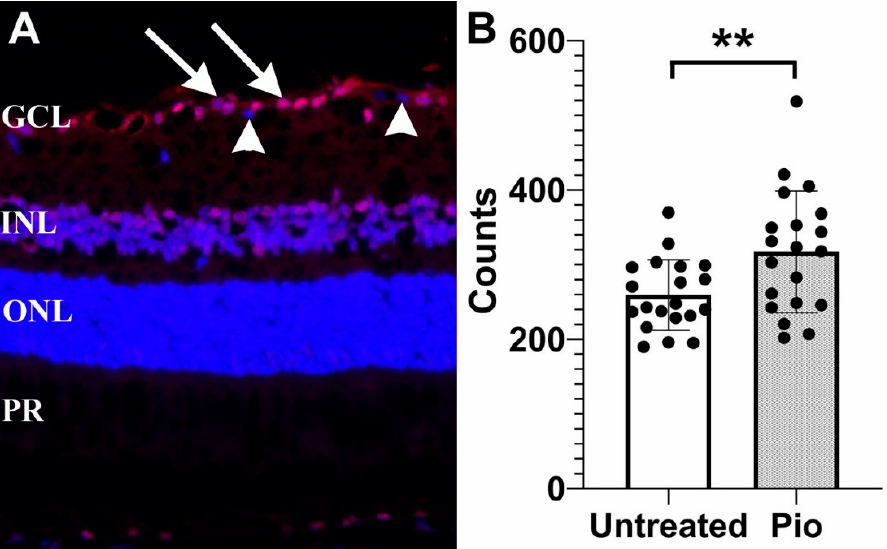
Figure 1. Protective effect of pioglitazone in DBA/2J mice. ( A ) Representative image showing γ -synuclein labeling of RGCs (arrows). Displaced amacrine cells are not bound by this antibody and are not counted (arrowheads) ( B ) RGC density in pioglitazone treated mice (Pio) is significantly higher than in untreated controls ( p = 0.009). Each dot represents one eye. GCL: Ganglion cell layer; INL: Inner nuclear layer, ONL: Outer nuclear layer, PR: Photoreceptor inner segments. **: p <